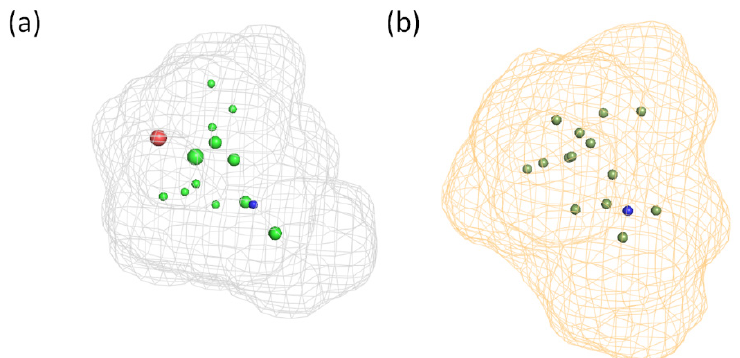
Figure 5. Pharmacophore models for substrates ( a ) (this study) and inhibitors ( b ) from reference [9] .